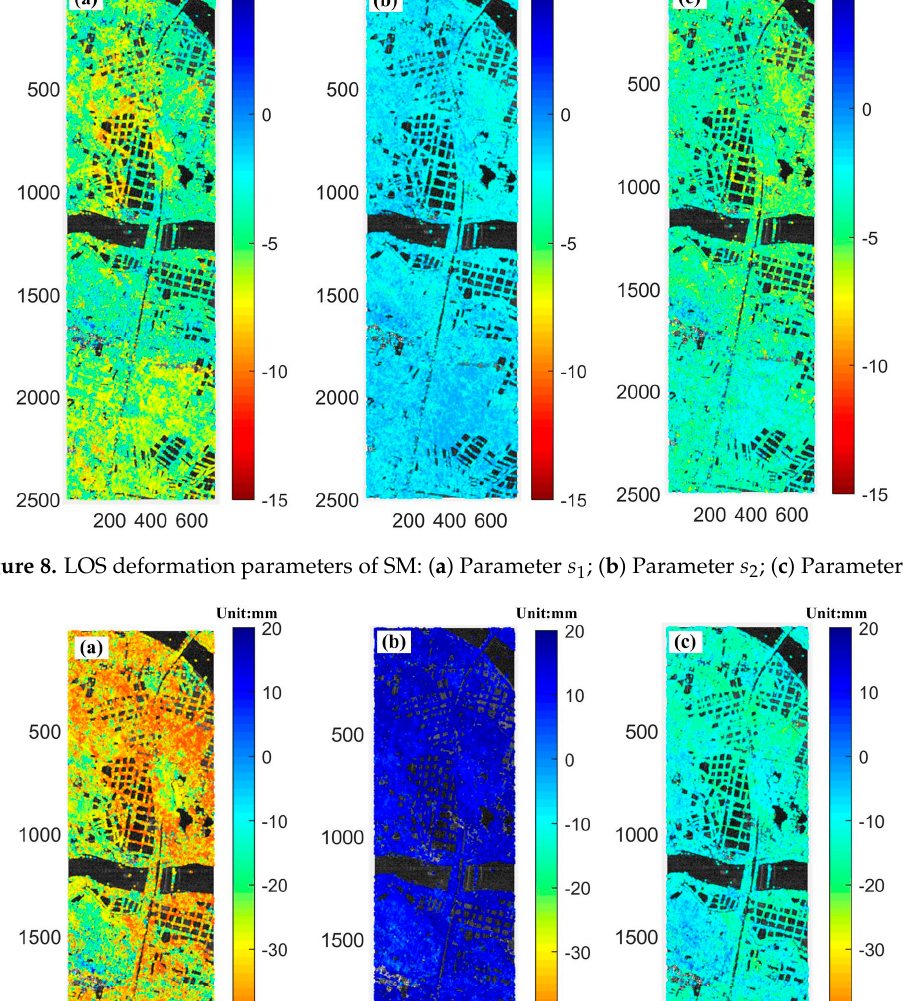
Figure 7. Deformation parameters of linear velocity models: ( a ) mean linear 𝑣 of MVM; ( b ) permanent 𝑣 of PVM